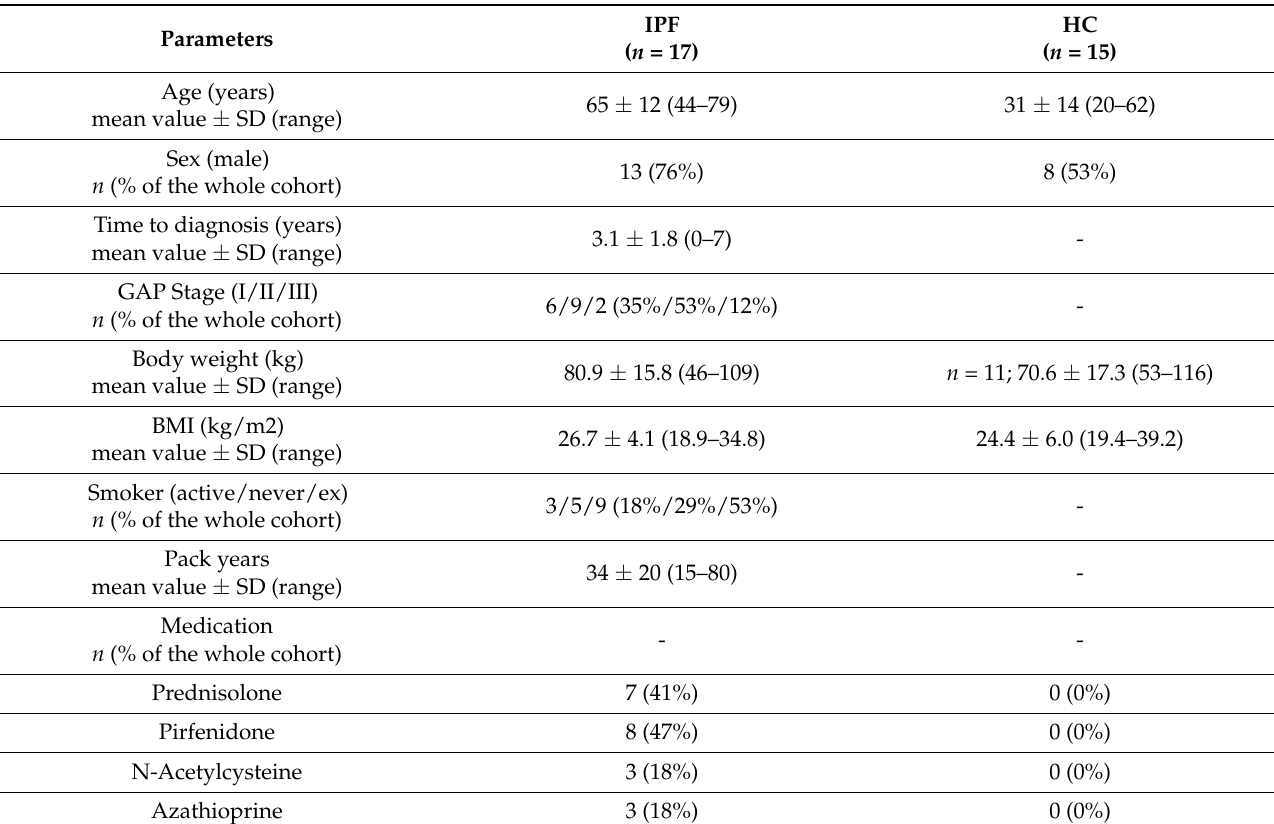
Table 1. Demographics and clinical parameters of our study cohorts.